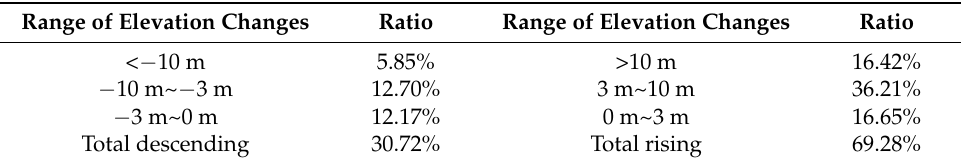
Table 4. Statistical results of elevation changes between ZY-3 DSM in 2015 and ASTER GDEM. Range of Elevation Changes